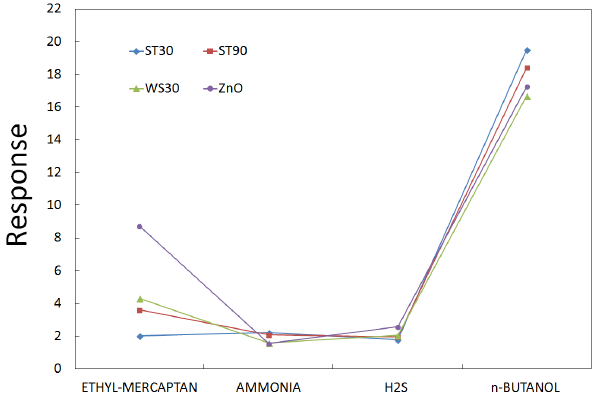
Figure 4. Responses vs. hydrogen sulfide from 0.01 to 1ppm dis- persed in a dry carrier.